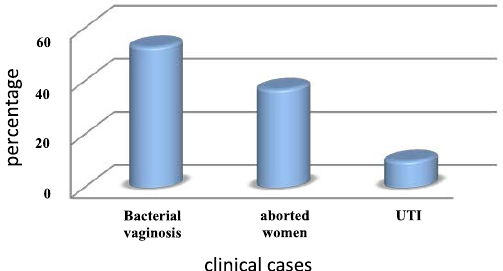
Fig. 1. Distribution of patients according to clinical diagnosis * UTI:- urinary tract infection